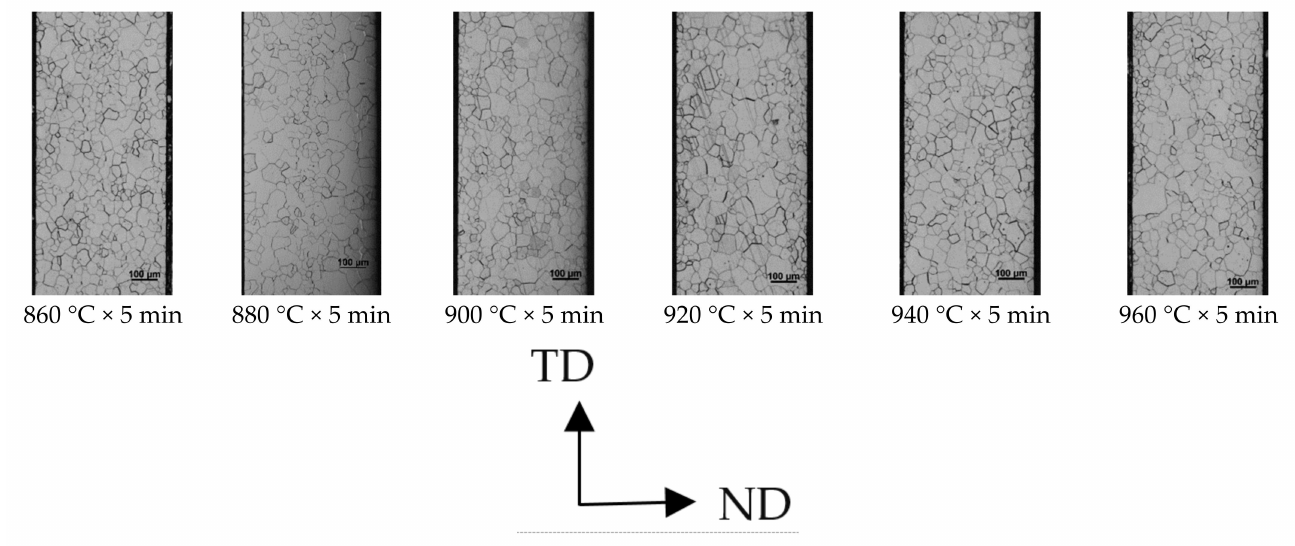
Figure 2. Microstructure of Fe-0.65%Si non-oriented electrical steel TD samples in different annealing processes.